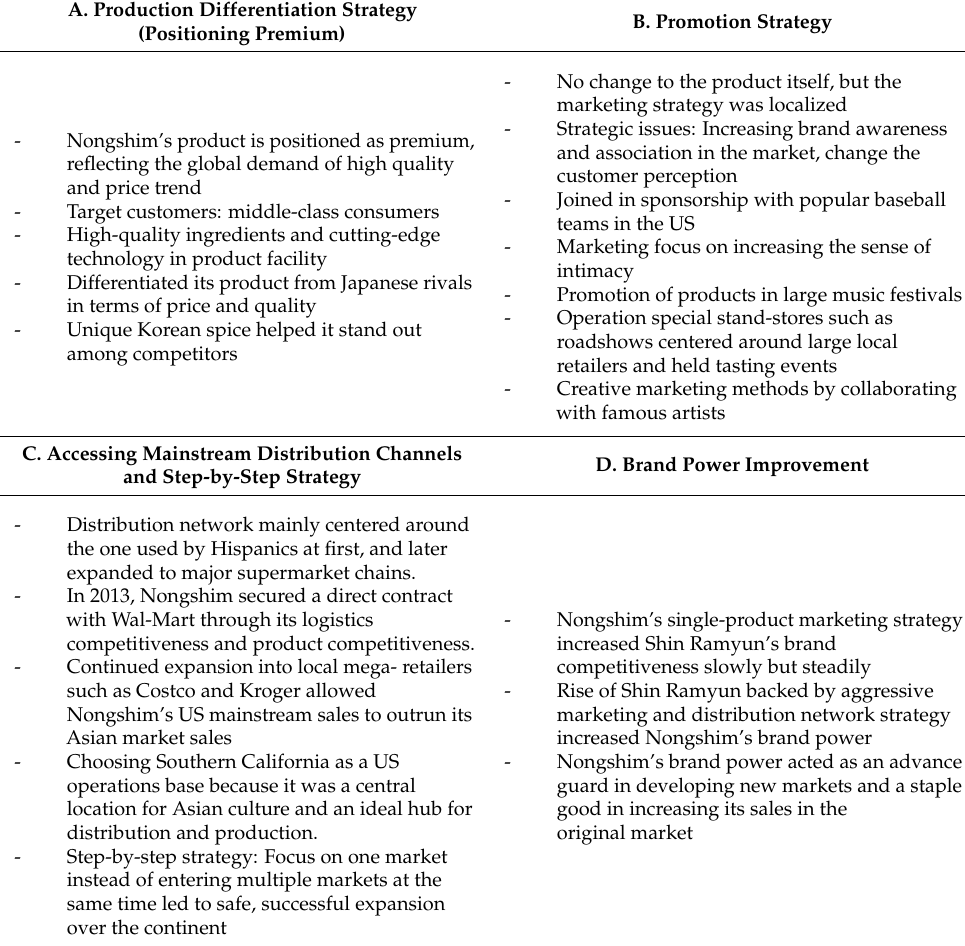
Table 4. Four Business Strategies of Nongshim in Stage 2.